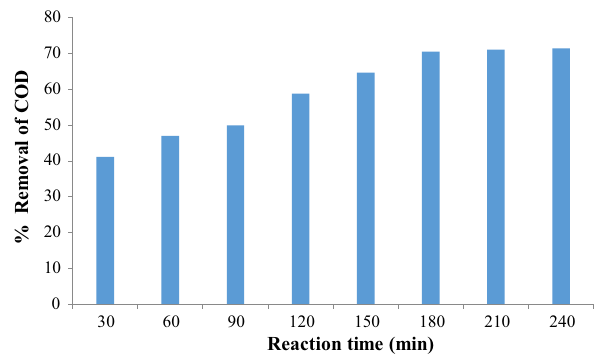
Fig. 4 Percentage removal of C.O.D. in photo fenton after rota- vapour distillation. Experimental conditions: FeSO 4 concentration (mg/L): 0.054 g, H 2 O 2 concentration: 1.8 ml, pH: 3, initial C.O.D: 34,000 mg/L, working volume: 500 ml